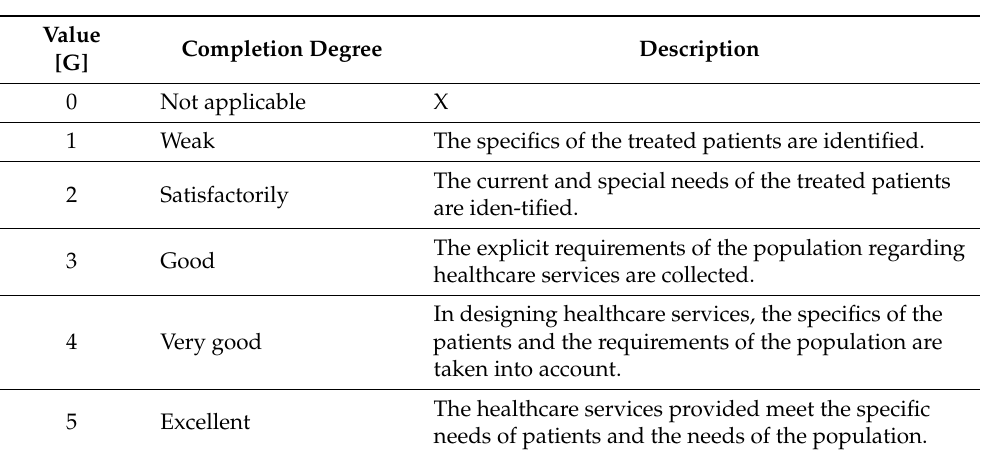
Table 4. Indicator evaluation grid P.A.2.1—Healthcare services accessibility.